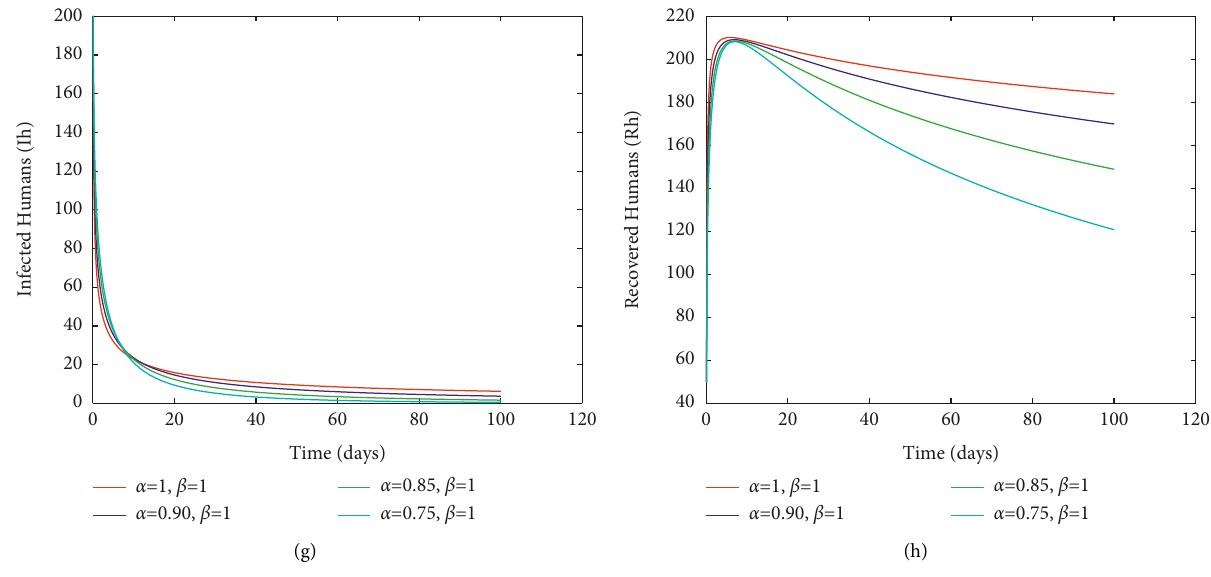
Figure 2: Simulation of fractional conformable model (7), when α � 1 , α � 0 . 90 , α � 0 . 85 , α � 0 . 75, and β �